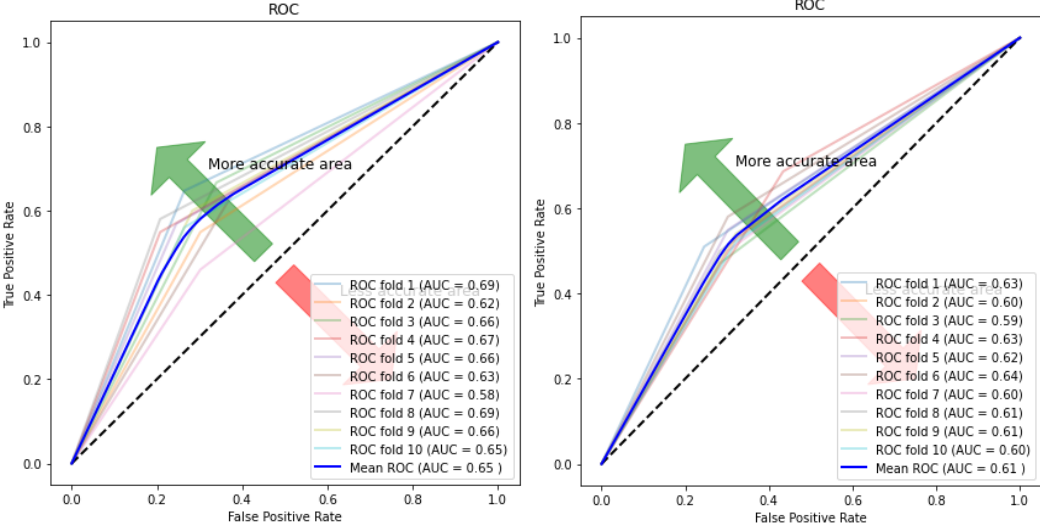
Figure 16. ROC curve and AUC values for autoencoder–RF ( Left ) and RF ( Right ).